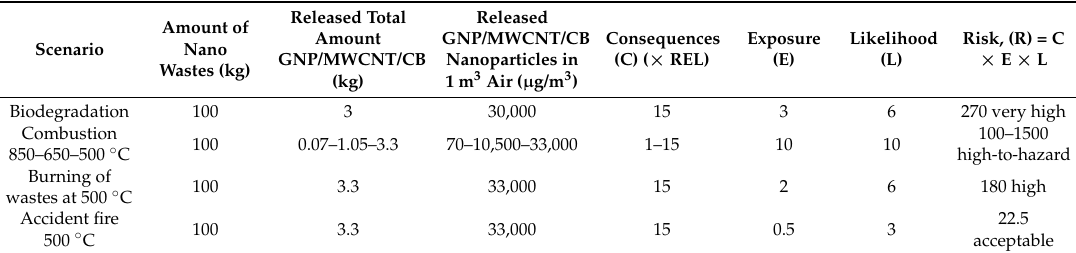
Table 3. Risk assessment by CEL model for the release of GNPs, MWCNTs and CB from